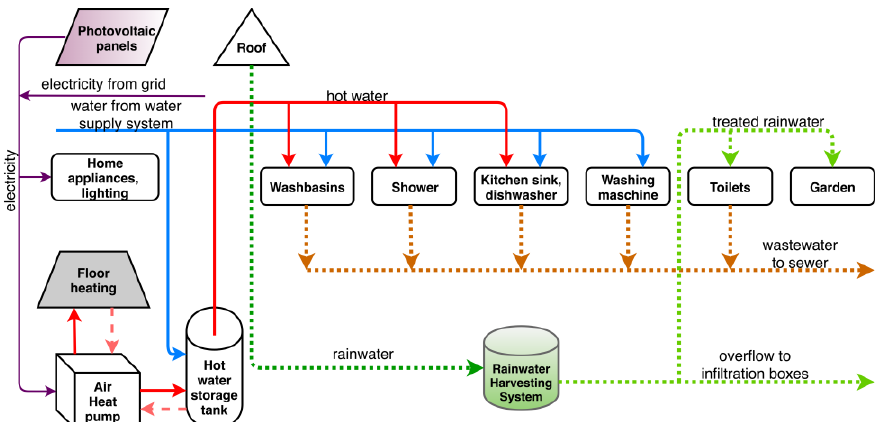
Figure 7. Diagram of system operation in Variant 4.